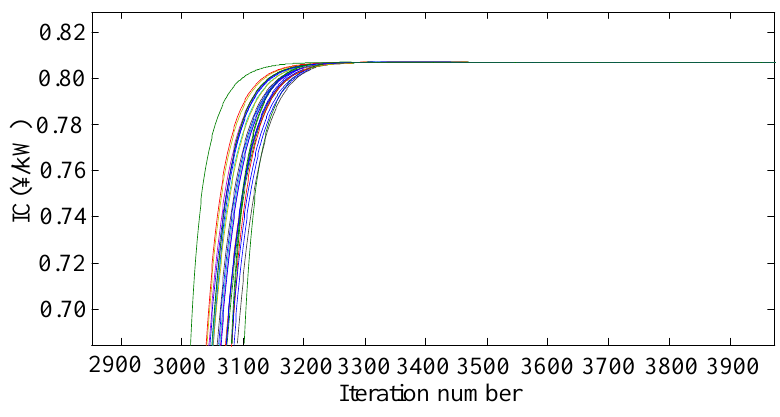
Figure 15. Communication topology of the 32 customers’ system.